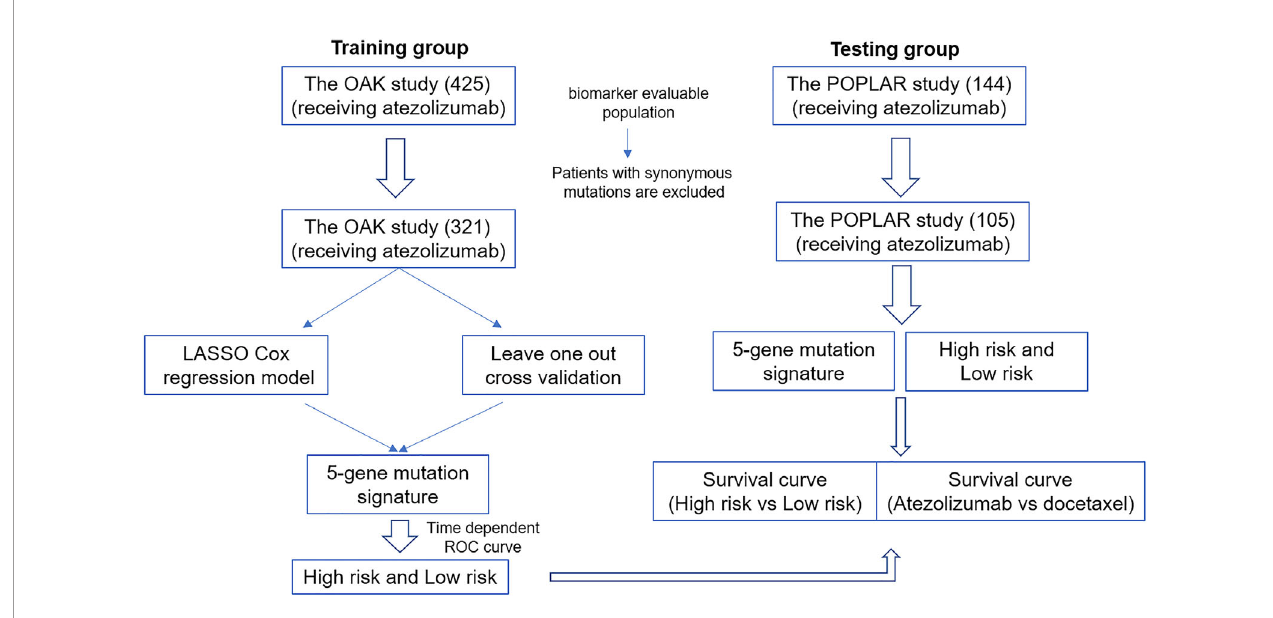
FIGURE 1 | Research and design fl ow